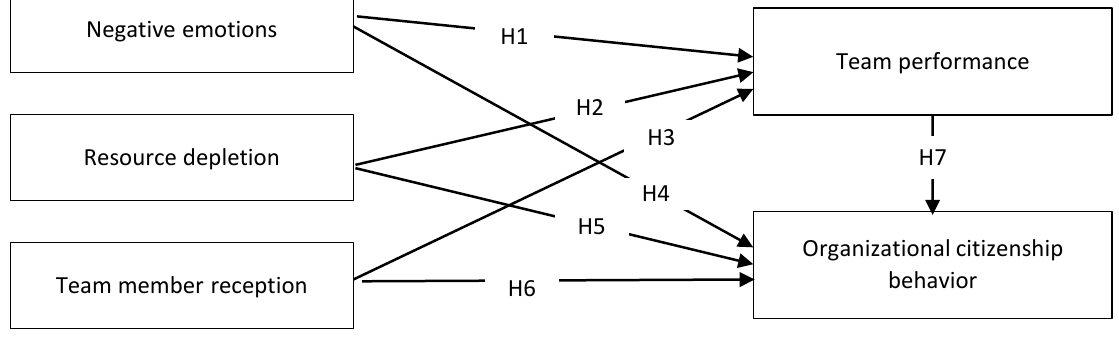
Figure 1. Proposed research